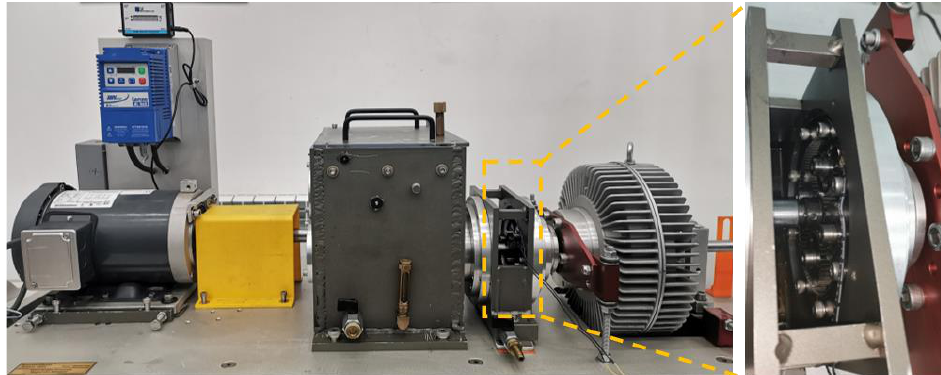
Figure 13. Measuring point layout.